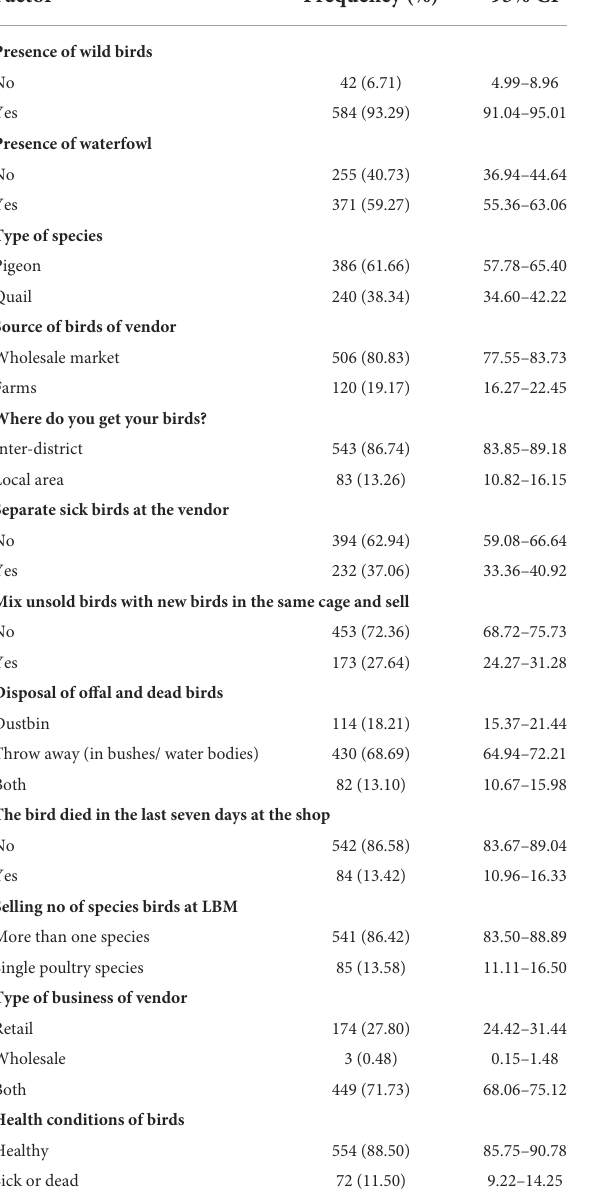
TABLE 1 Proportion and 95% CI of biosecurity and hygienic status of pigeons and quail vendor stall level and live bird markets